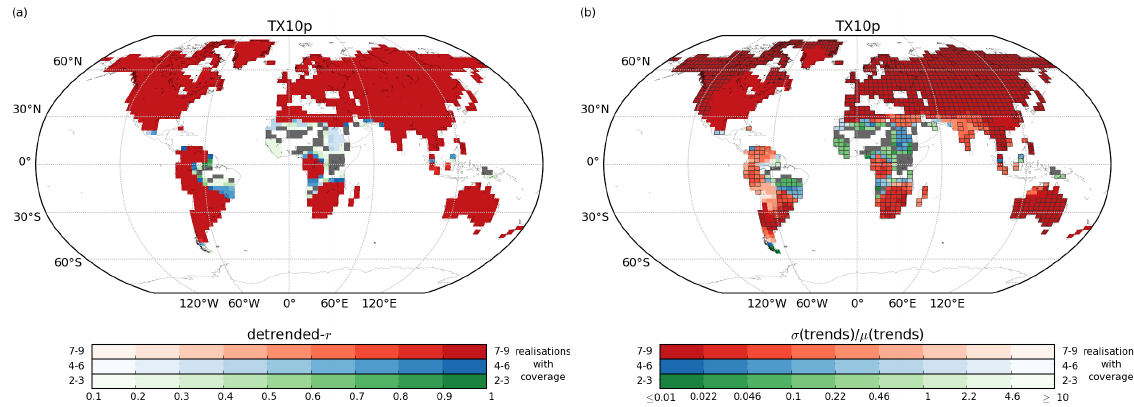
Figure 5. (a) The mean correlation coefficient of the detrended time series, r with HadEX2 for all the grid boxes and (b) the standard deviation of the trends divided by the mean trend ( σ/µ ) calculated for the period 1951 to 2010 for TX10p. Grey grid boxes are those where only one of the nine possible options for the number of stations within the DLS results in a value, green where two to three, blue where four to six, and red where seven to nine. In the right panel, boxes which have been outlined are those where there is high confidence in a non-zero trend in HadEX2.